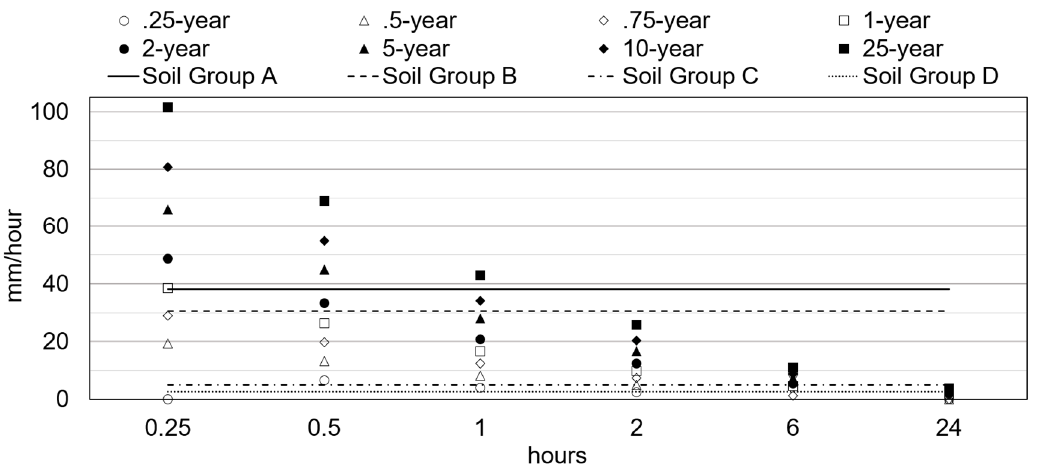
Figure 3. Event average precipitation intensity and soil group final infiltration rates.